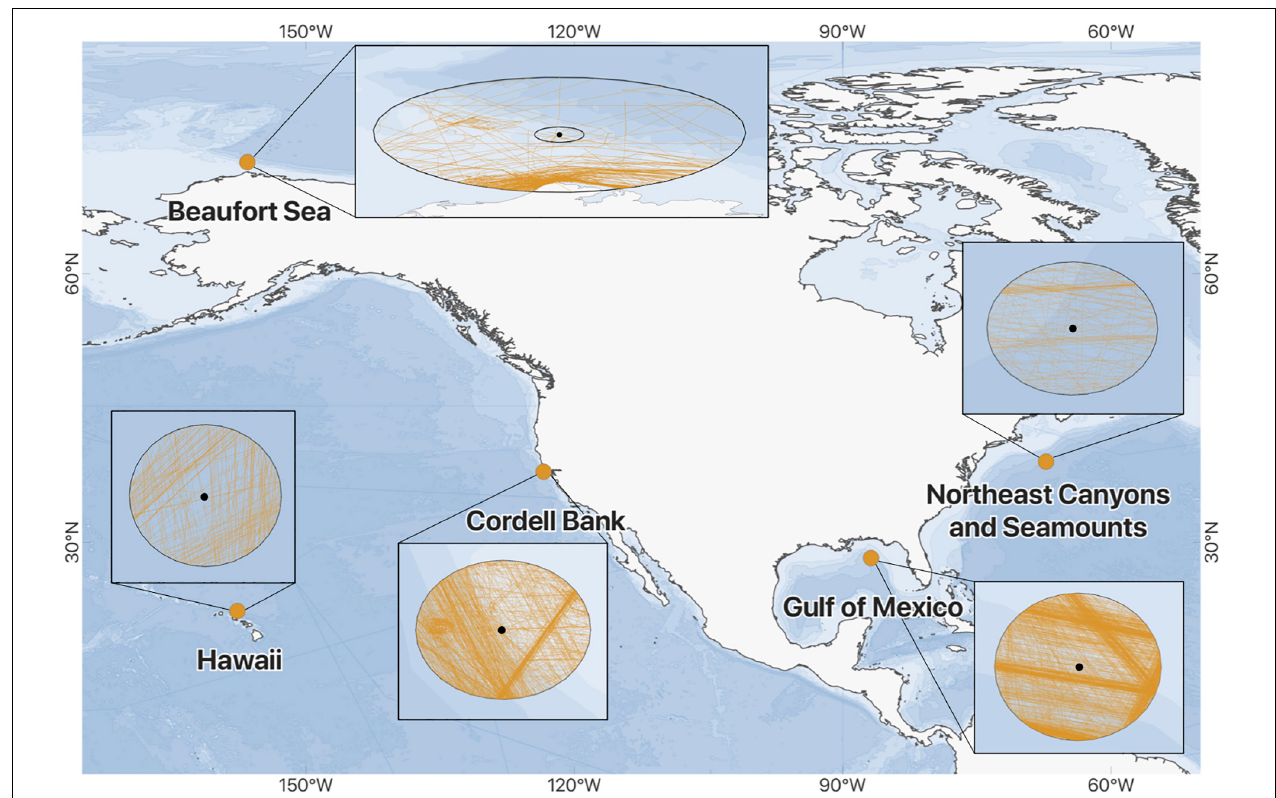
FIGURE 1 | Locations of the five NOAA/NPS Noise Reference Station Network sites where passive acoustic and vessel transit data were sampled between 1 January 2016 and 31 August 2017. A magnified image for each site shows AIS vessel track lines (orange) within each 20 km buffer radius, except at the Beaufort Sea site where both 20 and 150 km buffer circles are shown (see section “Materials and Methods”). The small black dot within each buffer represents the location of the hydrophone. Note that the shape of each buffer varies due to map